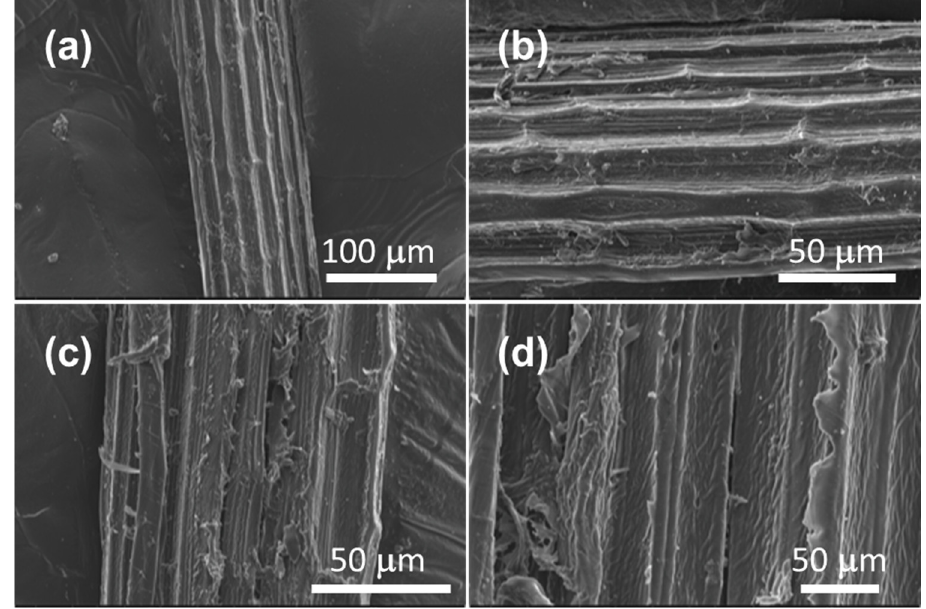
Figure 3. Microphotographs of the biosorbent prepared from agave bagasse at different magnifica- tions: ( a ) 100 µ m ( b ) 50 µ m ( c ) 50 µ m ( d ) 50 µ m.